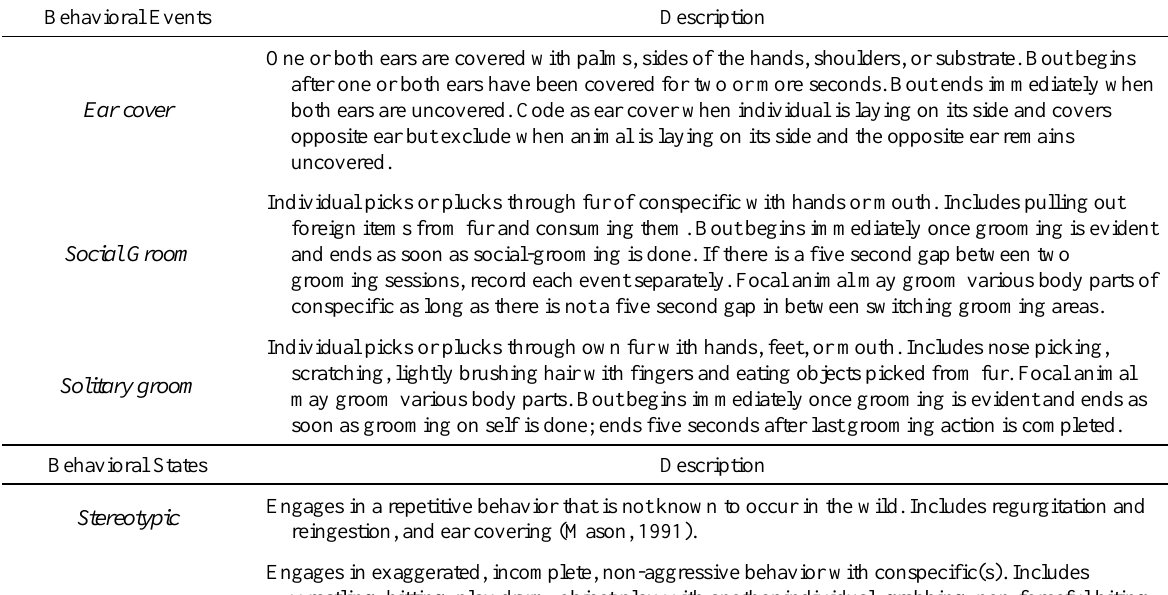
Ethogram Utilized for the Current